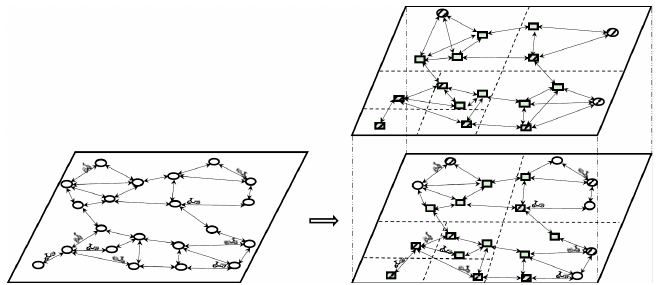
Figure 1. Methodology Overview.